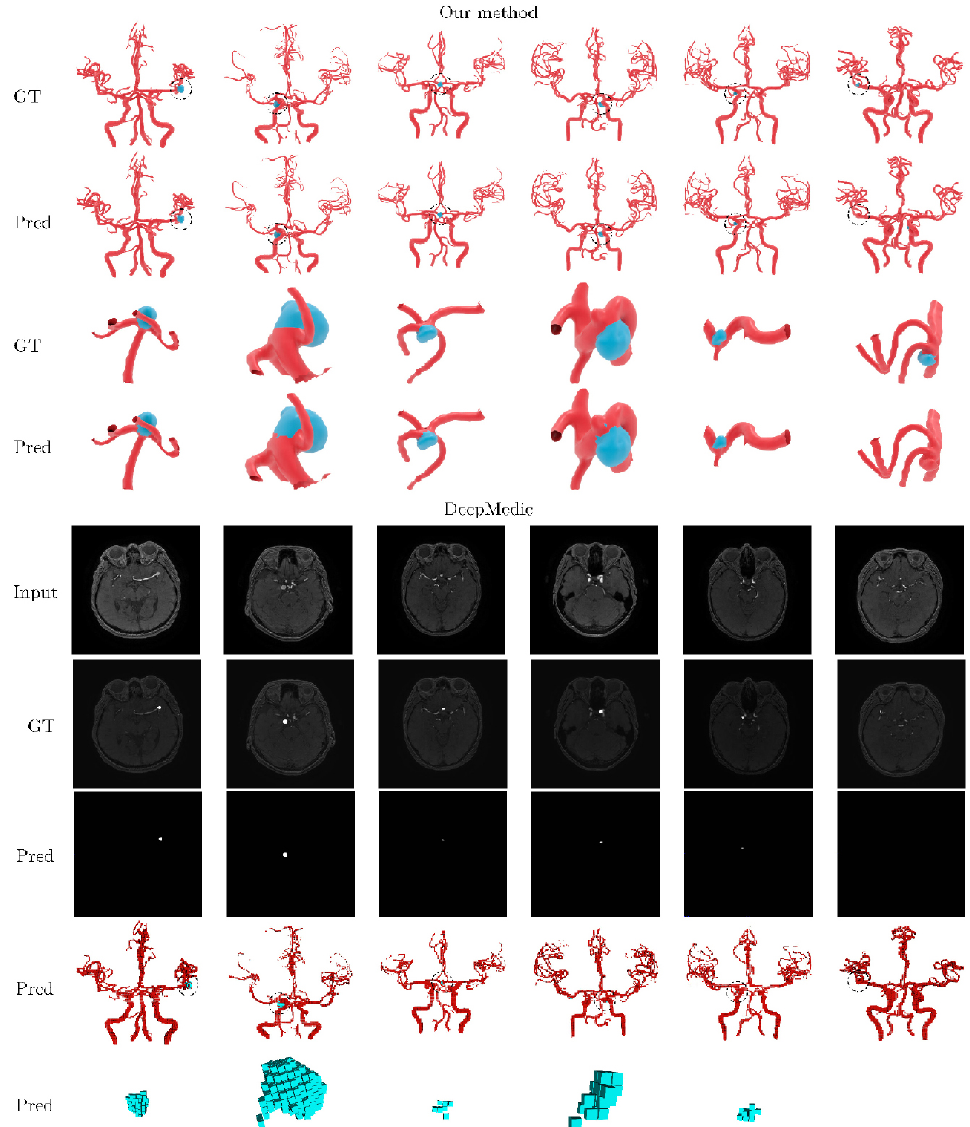
Fig. 9 Comparison of segmentation results. Left to right: both our method and DeepMedic yielded high segmentation accuracy on the first two examples. Our method yielded significantly better results than DeepMedic on the next three examples. Both our method and DeepMedic failed to obtain the parts with IA in the final example, as the fragment with the IA was filtered out by our classification network. We also show the results predicted by DeepMedic as volumes (last two